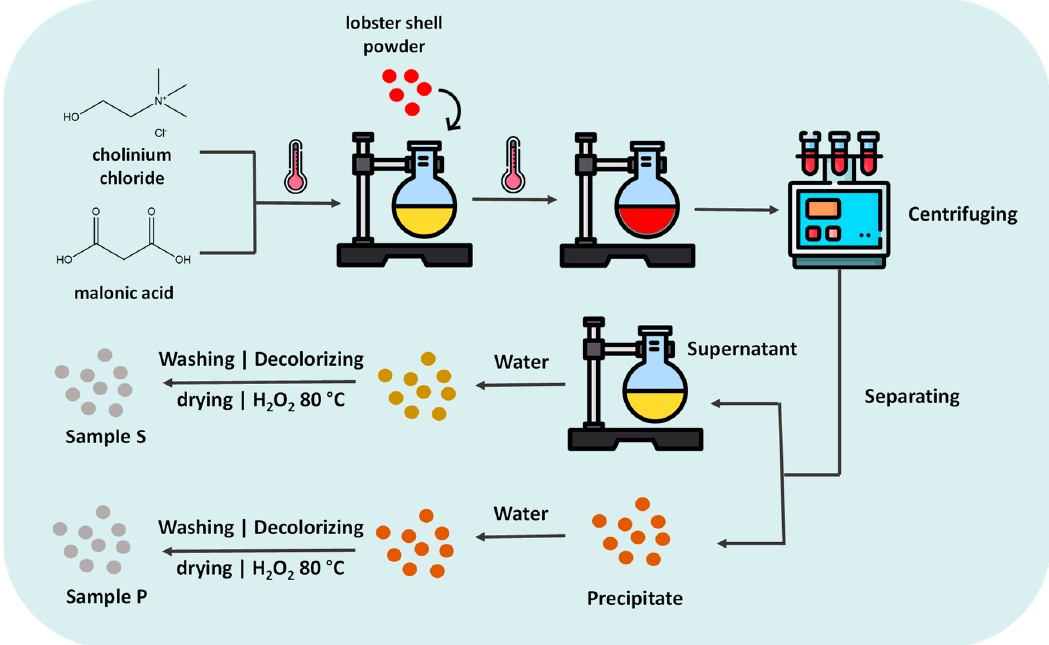
Figure 10. Schematic representation depicting the methodology for chitin extraction from lobster shells using [Ch]Cl:Malonic acid. Adapted from [280].